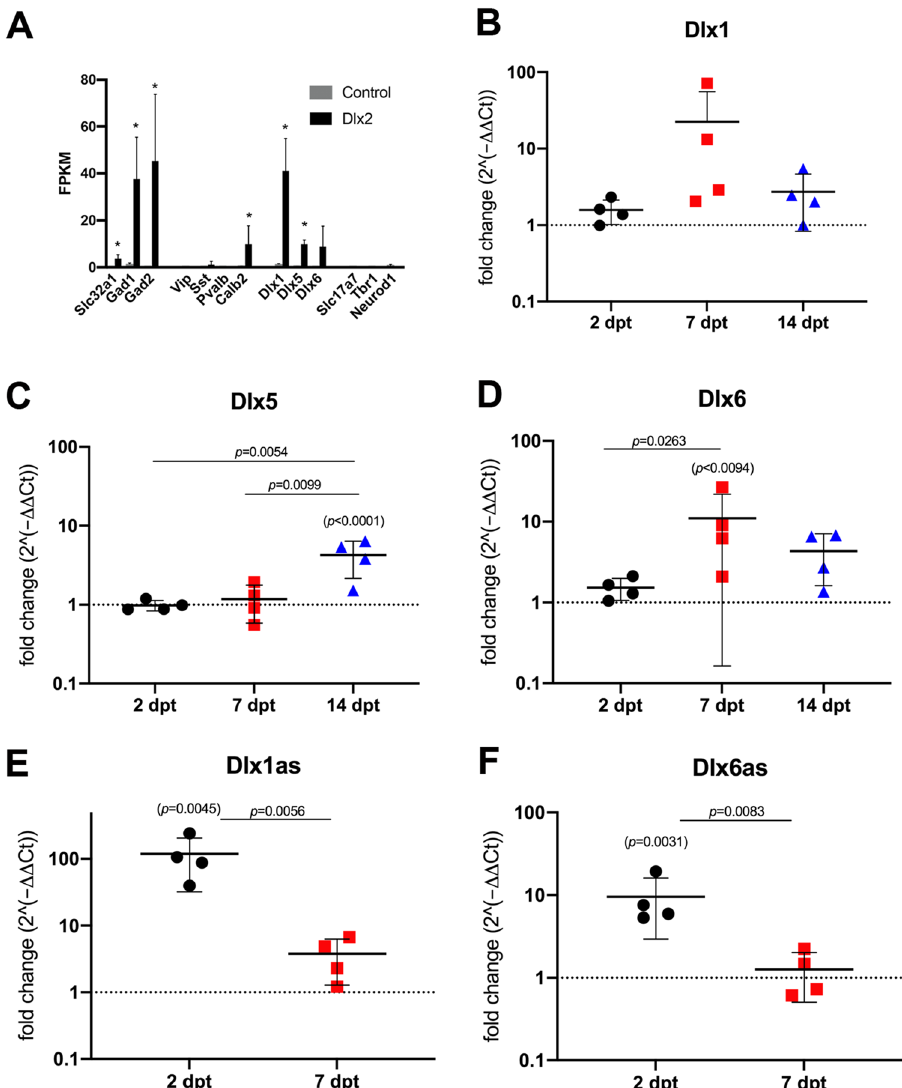
Figure 3. Dynamic changes in neuronal transcripts in Dlx2-transfected OPCs. ( A) FPKM values of key neuronal transcripts in control- and Dlx2- transfected OPCs. The p-adj values for the transcripts are as follows: Gad1 1.64 × 10 –19 , Gad2 1.21 × 10 –9 , Slc32a1 0.0001761, Dlx1 1.34 × 10 –23 , Dlx5 0.0007, Calb2 6.80 × 10 –10 . * denotes p-adj < 0.05. n = 3. ( B–F) The expression of Dlx1 ( B ), Dlx5 ( C ), Dlx6 ( D ), Dlx1as ( E ) and Dlx6as ( F ) transcripts at 2, 7, and 14 dpt obtained by qPCR. Values are for Dlx2-transfected OPCs and are normalized to control-transfected OPCs (black dotted line), and shown as fold-change over control-transfected OPCs in log 10 scale. The p -values for the comparison between Dlx2-transfected cells and control-transfected cells are indicated above each dataset in parentheses. The p -values for the comparison of Dlx2-transfected cells at 2, 7, and 14 dpt are indicated above the horizontal bars. Two-way ANOVA, Sidak’s multiple comparisons test, n =